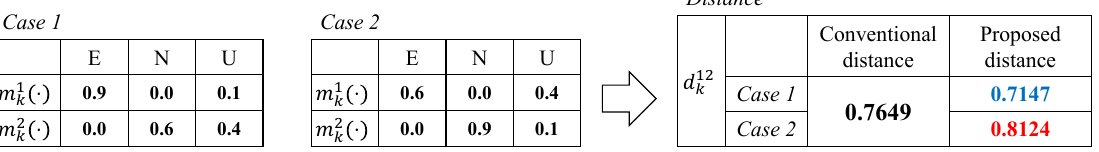
Figure 3. Example of the proposed distance given w ( e ) = 2, w ( n ) = 1, and w ( u ) =